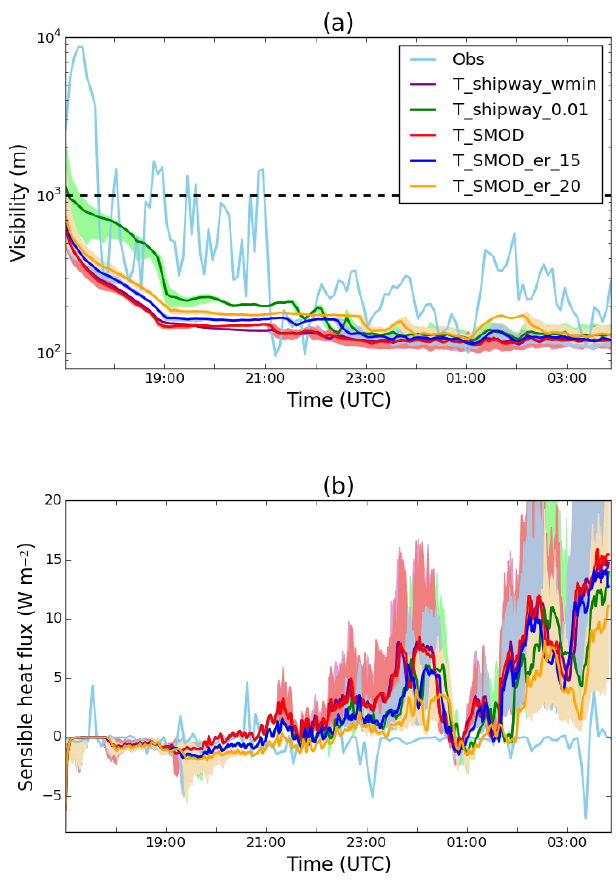
Figure 3. (a) Time series of the near-surface mean visibility (Vis;m) at a 2m altitude. Purple – T_shipway_wmin; green – T_shipway_0.01; red – T_SMOD; blue – T_SMOD_er_15; orange – T_SMOD_er_20; light blue – observations. (b) Time series of the surface sensible heat flux (Wm − 2 ). Purple – T_shipway_wmin; green – T_shipway_0.01; red – T_SMOD; blue – T_SMOD_er_15; orange – T_SMOD_er_20; light blue – observations. Minimum and maximum (a) visibility and (b) sensible heat flux are marked on the figure by the shaded